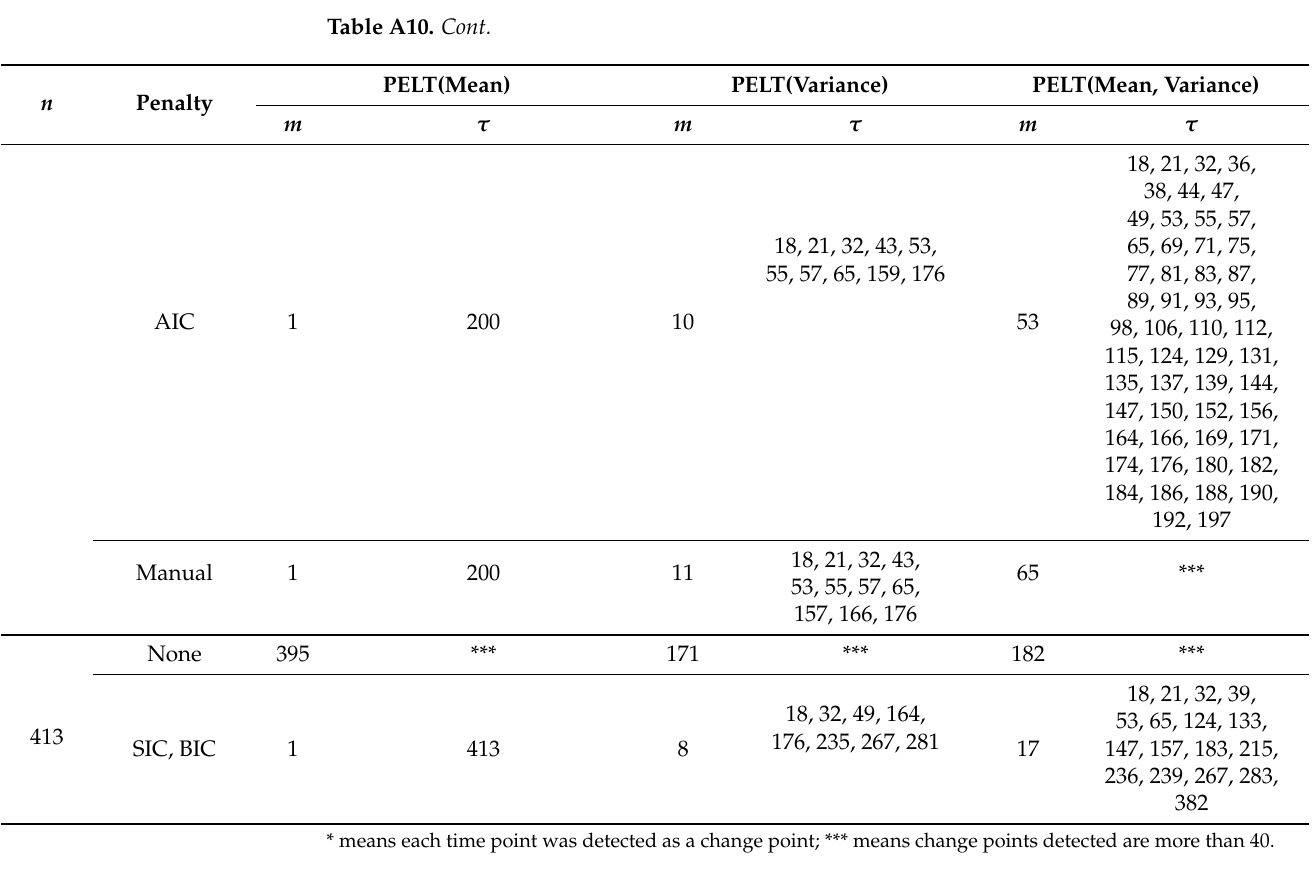
Table A11. PELT Algorithm Result for Poland’s COVID-19 Transmissibility